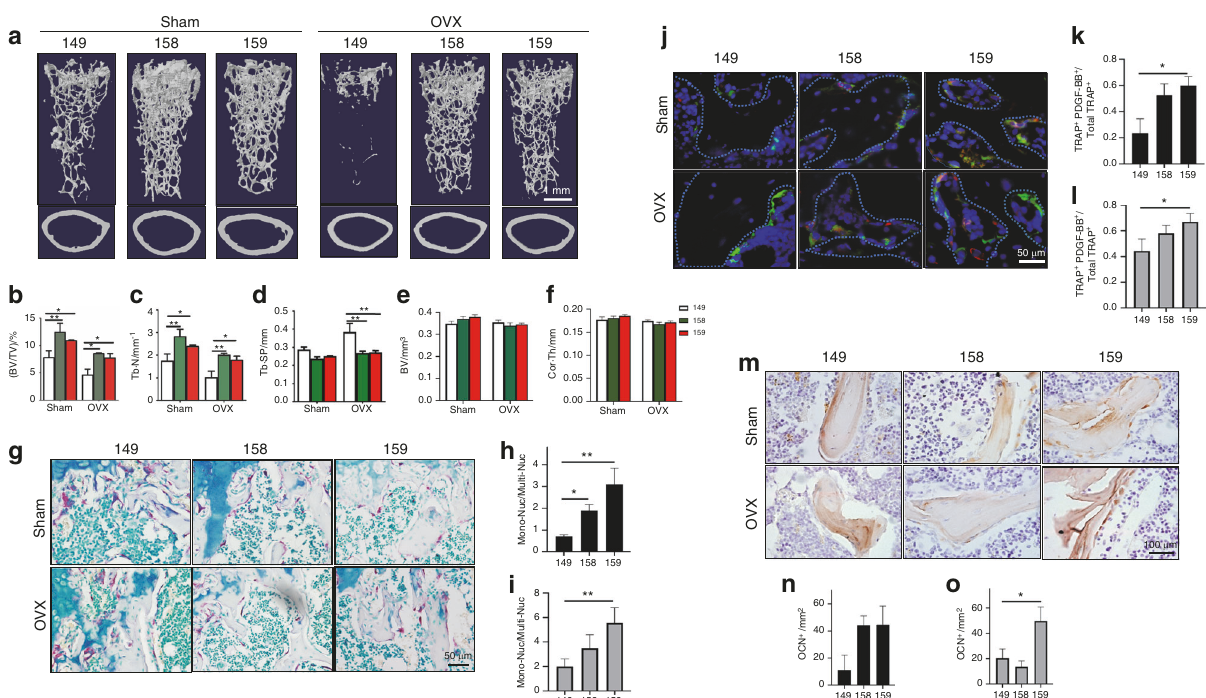
Fig. 6 Injection of the Siglec-15 neutralizing antibody prevented bone loss in estrogen-depleted osteoporotic mice. All data in this fi gure are derived from 5-month-old C57BL/6 mice that underwent OVX at 3 months old and were treated with NP-149 (control antibody), NP-158 (Siglec- 15 neutralizing antibody 1), or NP-159 (Siglec-15 neutralizing antibody 2) for 2 months after surgery. a Representative three-dimensional µCT images of the mouse femurs. Quantitative analysis of the µCT scan in a : b BV/TV percentage trabecular bone volume, c Tb. N trabecular number, and d Tb. Sp trabecular separation. e BV cortical bone volume, f Cor. Th cortical bone thickness. n = 5, * P < 0.05, ** P < 0.01. g Representative images of TRAP staining of the distal femurs. Quantitative analysis of TRAP staining in the sham-operated group ( h ) and ovariectomy group ( i ). Mon-Nuc: mononuclear TRAP + cells, Multi-Nuc: multinuclear TRAP + cells. n = 5, ** P < 0.01. j Coimmuno fl uorescence staining of TRAP (green) and PDGF-BB (red) in the trabecular bone of mouse distal femurs. Quantitative analysis of the ratio of TRAP/PDGF-BB double-positive fl uorescent cells in TRAP + cells in the sham-operated ( k ) and ovariectomy ( l ) groups. n = 5, * P < 0.05. m Representative images of immunohistological staining of osteocalcin in mouse distal femurs. Quantitative analysis of osteocalcin staining in the sham-operated ( n ) or OVX ( o ) groups. n = 5, * P <